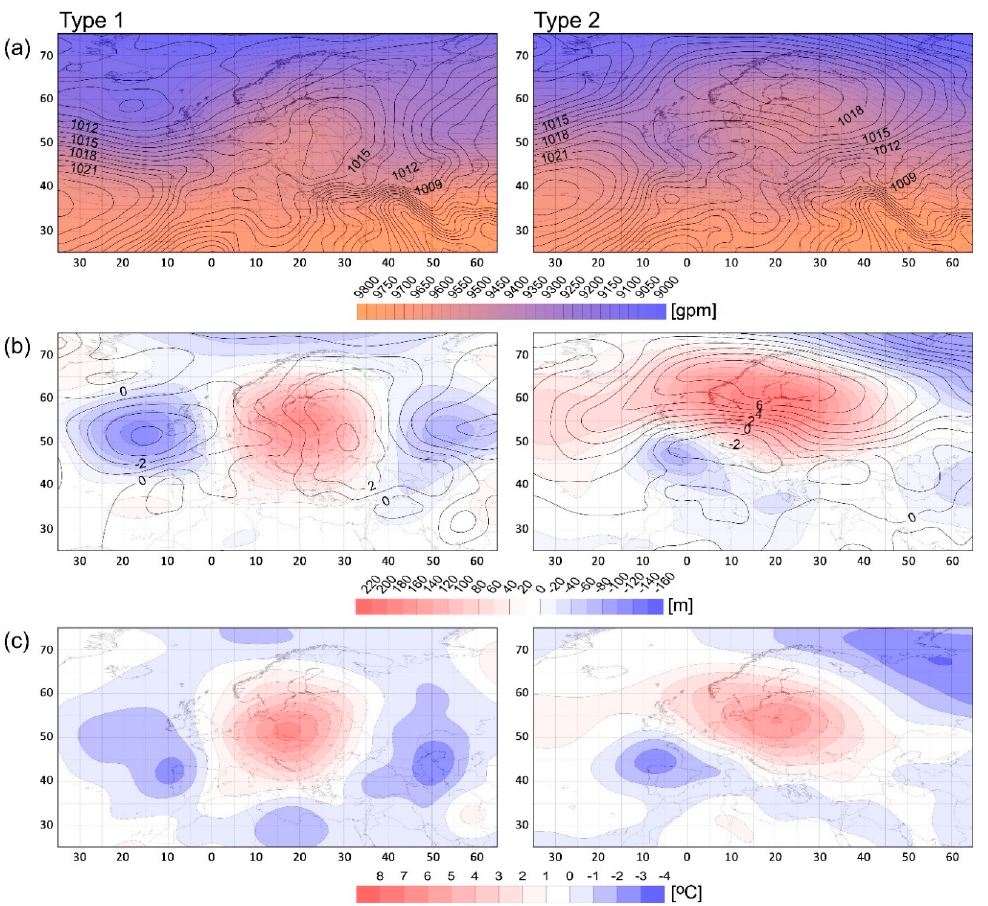
Figure 8. Mean SLP (black lines) and z300 hPa (colour shades) ( a ); anomalies of SLP (black lines) and z300 hPa (colour shades) ( b ); and anomalies of T850 (colour shades) ( c ) during the analysed waves of hot nights for types 1 and